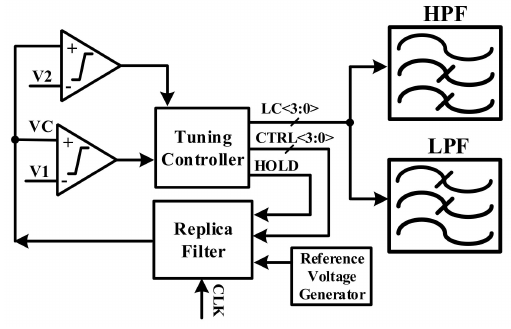
Figure 20. Block diagram of filter tuning.